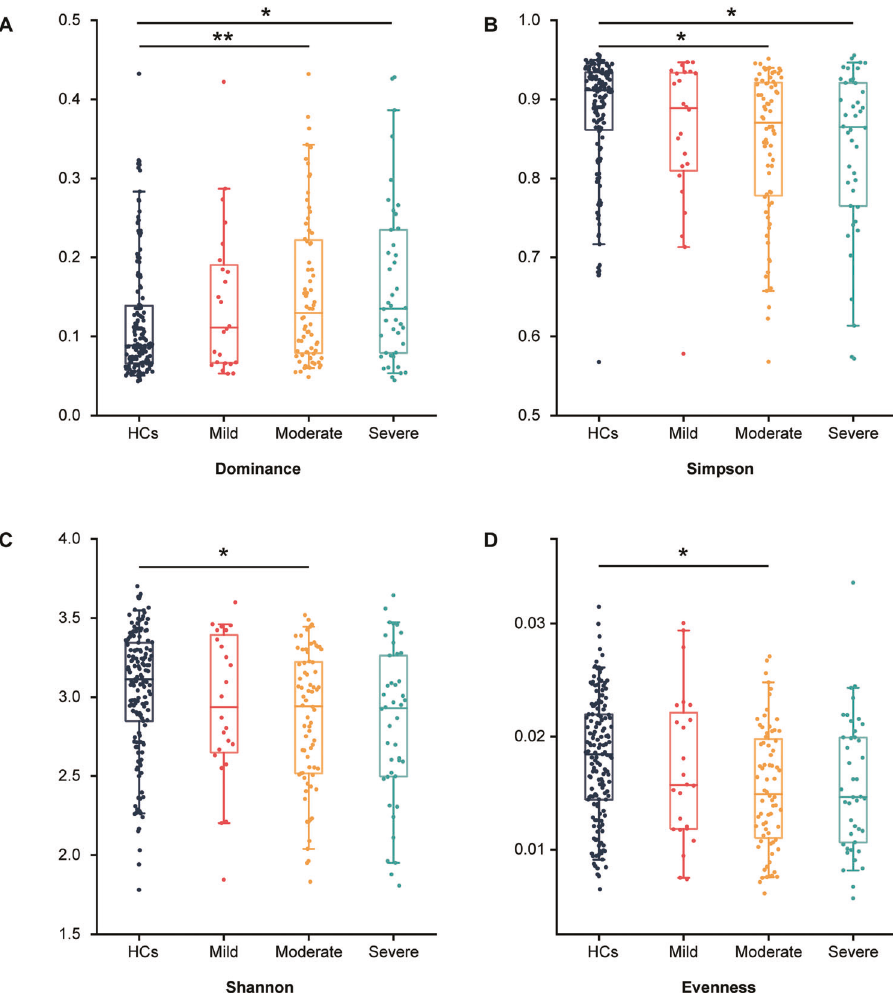
Fig. 1 The α -diversity index analysis among HCs and MDD subgroups. A – D The box plots showing α -phylogenetic diversity analysis results, the dominance index increased in moderate and severe groups relative to HCs while simpson was decreased, while there was no signi fi cant difference between mild and HCs. In moderate group, the shannon and evenness indexes were signi fi cantly lower than that in HCs. (HCs, n = 155; mild, n = 24; moderate, n = 72; severe, n = 42; * p < 0.05; ** p < 0.01; Kruskal – Wallis rank sum